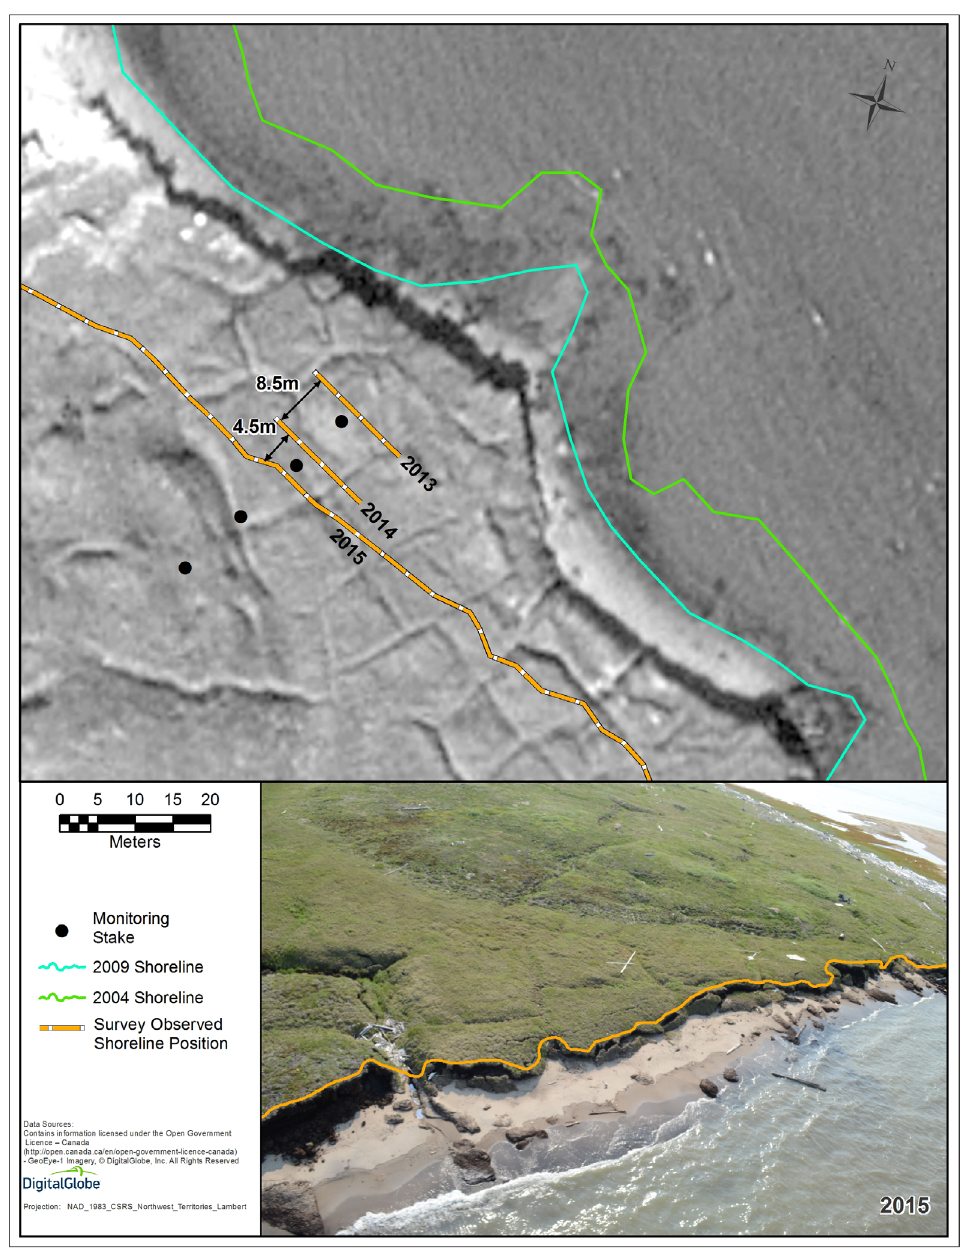
Fig. 12: 2015 shoreline position at Toker Point. From this review of shoreline erosion calculations at Toker Point, it has been demonstrated that using aggregated time periods can yield useful results for generalized, region-wide overviews of historical shoreline change rates. However, the inclusion of further recent imagery and thereby shorter intervals of analysis can result in more nuanced models of shoreline change in the direct vicinity of known archaeological remains. Current forecasts have predicted changes in the seasonality of erosion forcing mechanisms, such that protracted open water periods coincide more often with strong autumn/winter storm events (Manson, Solomon 2007). Thus, the ability to detect sporadic, high-impact erosion events can be of tremendous use to cultural landscape management initiatives both now and in the